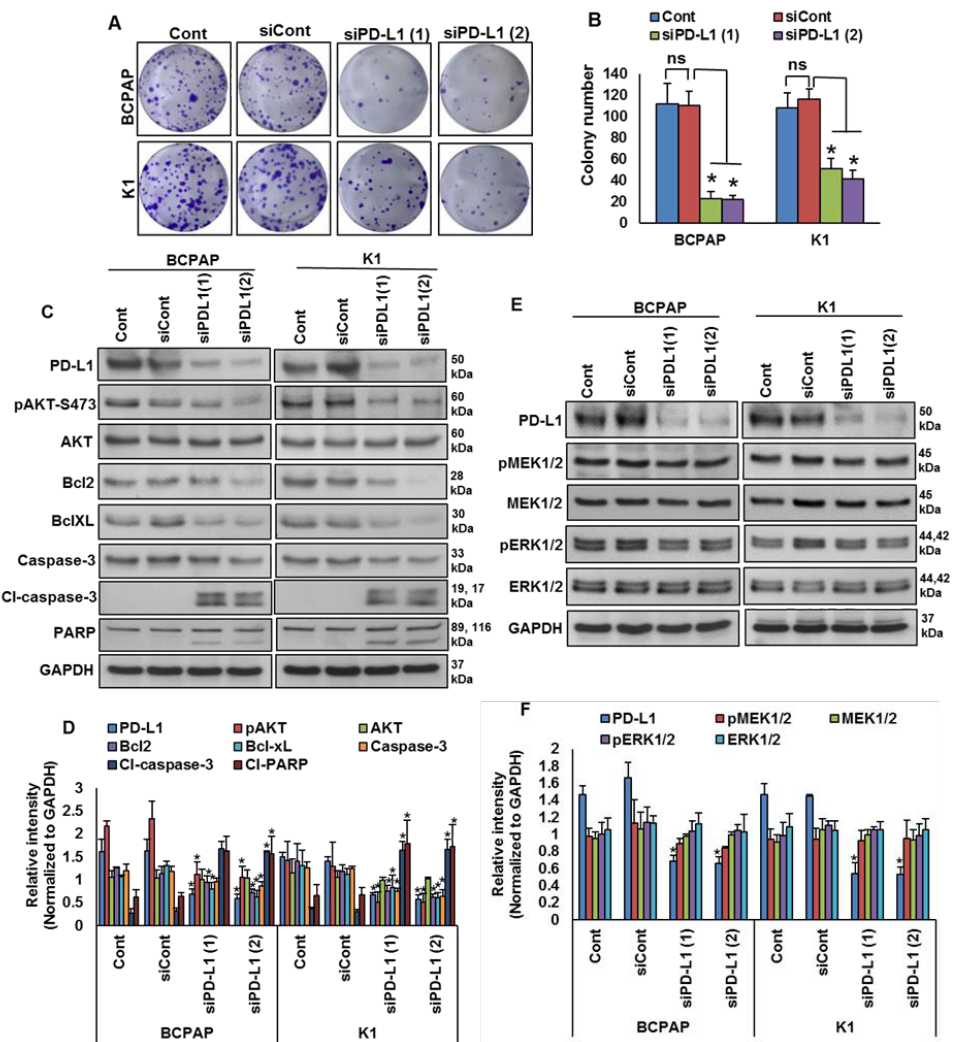
Figure 5. Silencing of PD-L1 decreases cell growth of BRAF -mutated cell lines. ( A , B ) Knockdown of PD-L1 decreases clonogenicity. BRAF -mutated PTC cells were transfected with scrambled siRNA and two different PD-L1 siRNAs (50 nM). Forty-eight hours post-transfection, cells (5 × 10 2 ) were re-seeded into a 6-well plate, and grown for an additional 6–8 days, then stained with crystal violet and colonies were counted. Data presented in the bar graphs are the mean ± SD of three independent experiments ( n = 3), which were repeated at least two times with the same results. * Indicates a statistically significant difference compared to siRNA control with p < 0.05. ( C , D ) Knockdown of PD-L1 decreases AKT phosphorylation and downregulates the expression of anti-apoptotic proteins and induces the cleavage of caspase-3 and PARP. BRAF - mutated PTC cells were transfected with scrambled siRNA and two different PD-L1 siRNAs (50 nM). Forty-eight hours post-transfection, cells were lysed and equal amounts of proteins were separated and immuno-blotted with antibodies against PD-L1, pAKT, AKT, Bcl-2, Bcl-xL, caspase-3, cleaved caspase-3, PARP and GAPDH as indicated. Western blots were quantified and data are presented as mean ± SD of three independent experiments ( n = 3). * Indicates a statistically significant difference compared to siControl with p < 0.05. ( E , F ) Knockdown of PD-L1 caused no effect on MEK/ERK activation. BRAF -mutated PTC cells were transfected with scrambled siRNA and two different PD-L1 siRNAs (50 nM). Forty-eight hours post-transfection, cells were lysed and equal amounts of proteins were separated and immuno-blotted with antibodies against PD-L1, pMEK1/2, MEK1/2, pERK1/2, ERK1/2 and GAPDH. Western blots were quantified and data are presented as mean ± SD of three independent experiments ( n = 3). * Indicates a statistically significant difference compared to siControl with p <